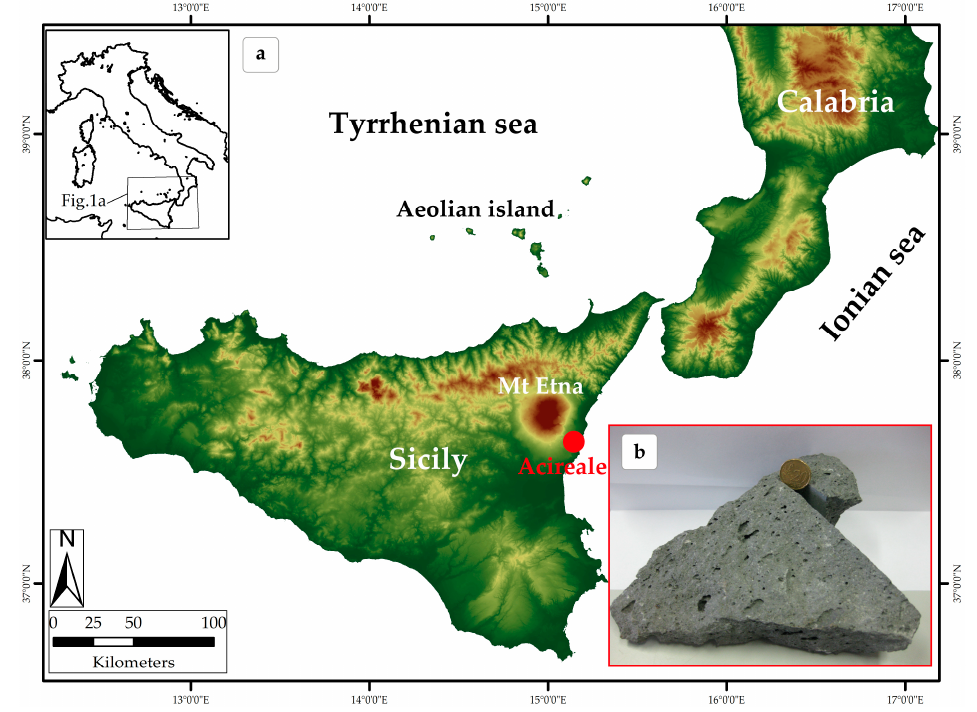
Figure 1. ( a ) Location map of the sampling site (red point) ( b ) Basaltic rock sample (AC1R2) collected near Acireale and used in the experiment.